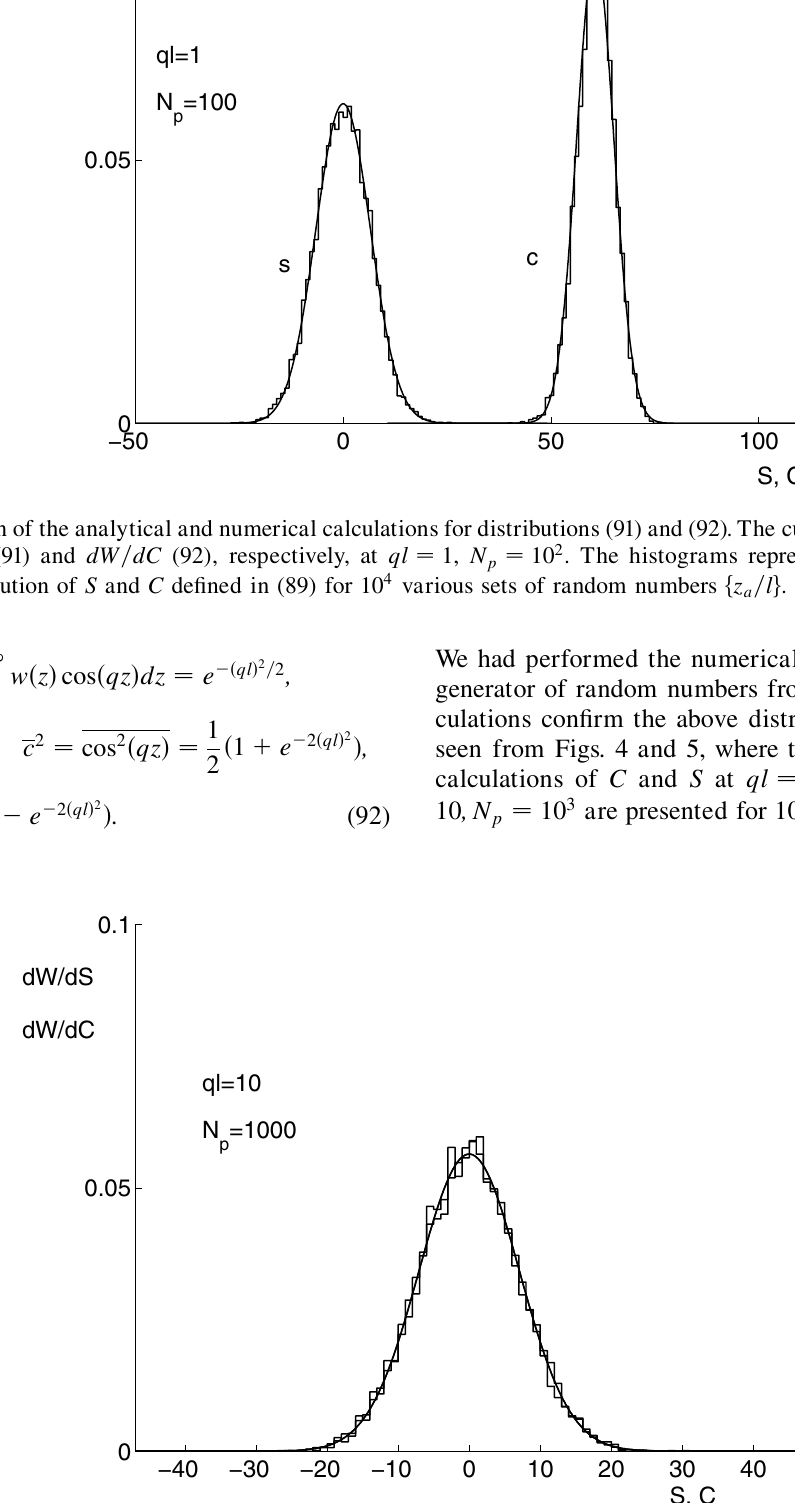
FIG. 5. The same as in Fig. 4, but for ql (cid:7) 10 , N